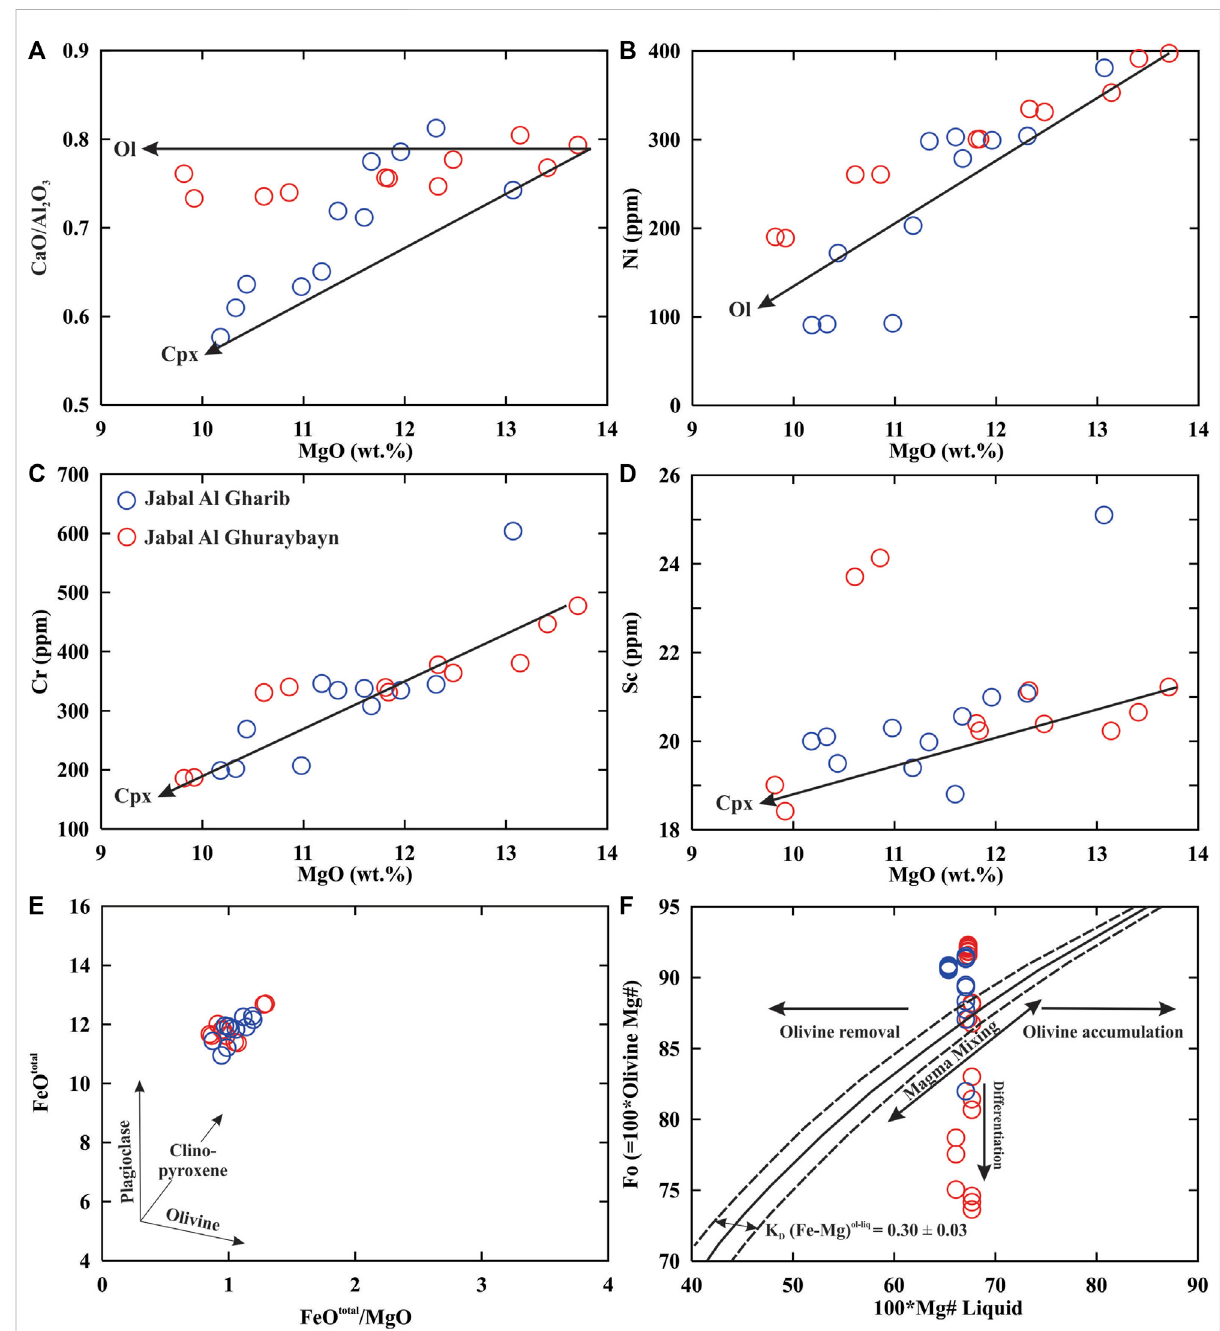
FIGURE 7 PlotsofMgOvs. (A) CaO/Al 2 O 3 , (B) Ni, (C) Cr,and (D) Scshowingpossiblefractionalphasesduringbasanitemagmaevolution. (E) PlotofFeO total vs. FeO total /MgO ratio. Removal vectors are after Albarè;de (1992). (F) Rhodes diagram showing olivine Fo% vs. bulk-rock Mg#. Olivine – liquid equilibrium fi eld is after Roeder and Emslie